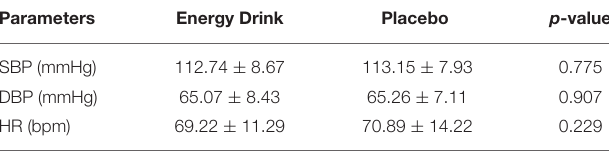
TABLE 2 | Cardiovascular parameters at baseline ( n =